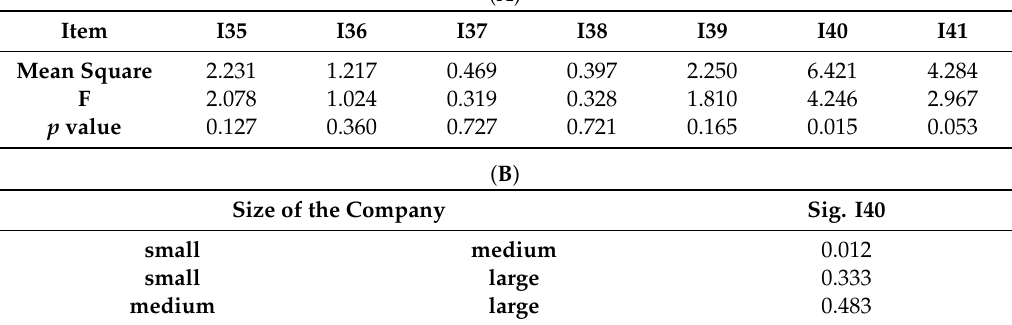
Table 14. ( A ) Significant di ff erences in retention of talents according to size of the company (ANOVA) and ( B ) Post hoc tests for significant di ff erences in retention of talents (Tukey